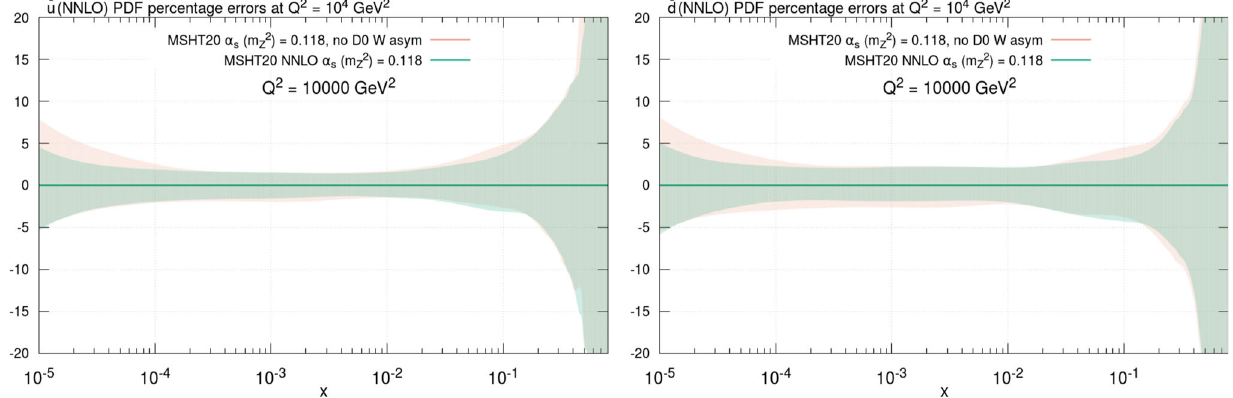
Fig. 63 (Left) ¯ u and (right) ¯ d PDF percentage errors at Q 2 = 10 4 GeV 2 at NNLO in both the MSHT20 default fit and the same with the removal of the DØ W asymmetry data, and without fitting the electron asymmetry